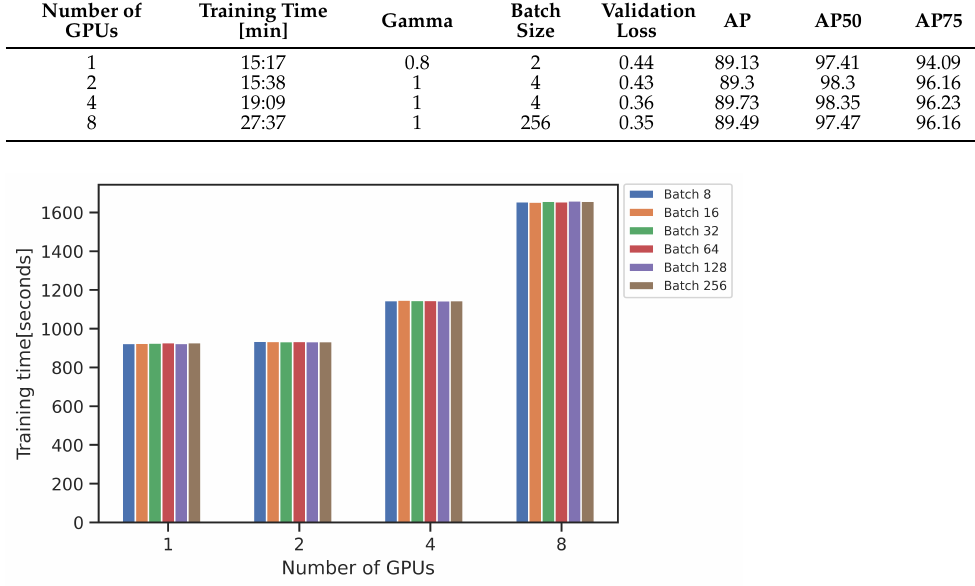
Figure 5. Training times for mask_rcnn_R_101_FPN_3x with 1000 epochs with different batch